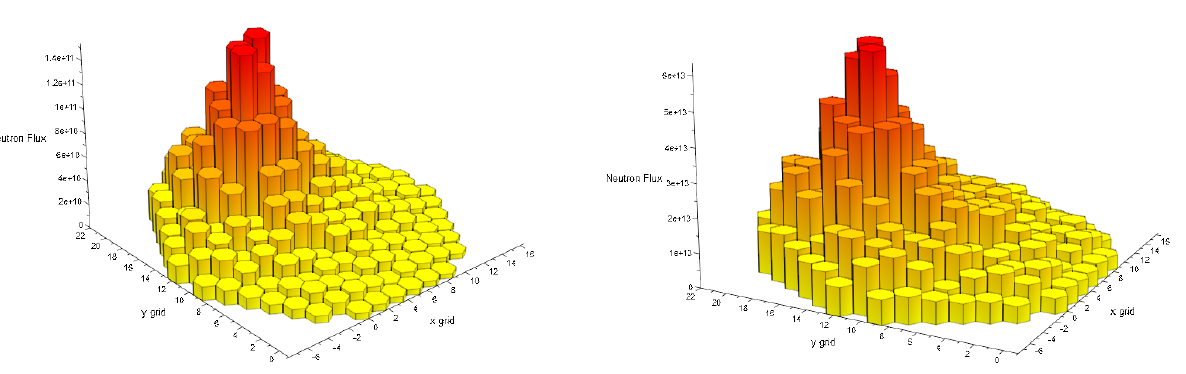
Figure 10. Averaged thermal flux. Figure 11. Averaged thermal flux after 100